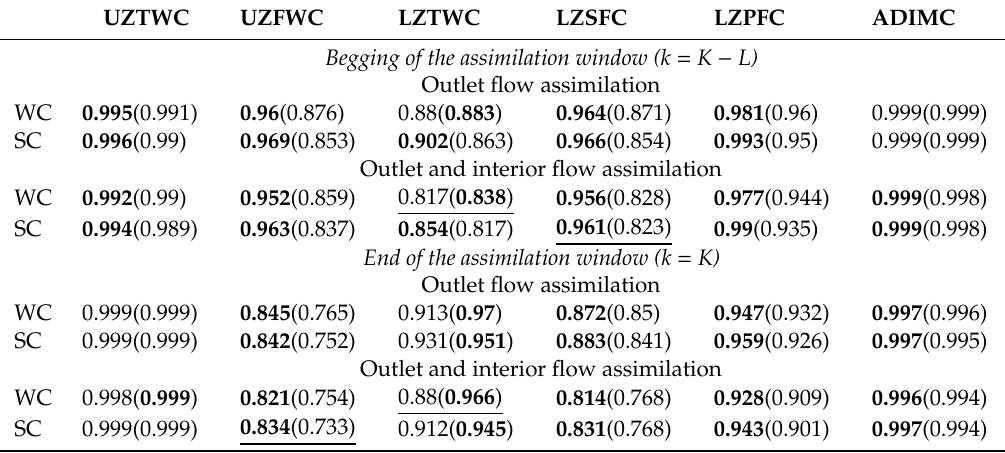
Table 3. Time-averaged spatial correlation of background and updated model states. Values in the parenthesis represent correlation from VAR, or r V , otherwise from MVAR, or r M . Bold font highlights a larger value between r V and r M . Underscored is the pair showing the minimum or maximum value of r M − r V at either k = K − L or k = K . WC and SC represent the model applied as a weak- or strong-constraint to the assimilation problem,